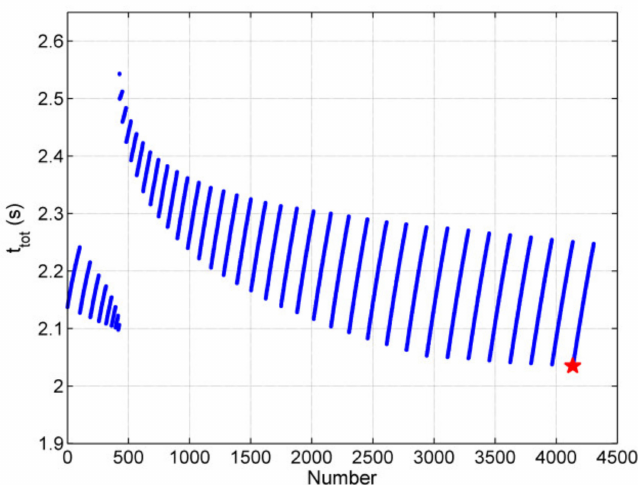
Figure 8. Calculation results of total charging time corresponding to all the variable vectors in X .